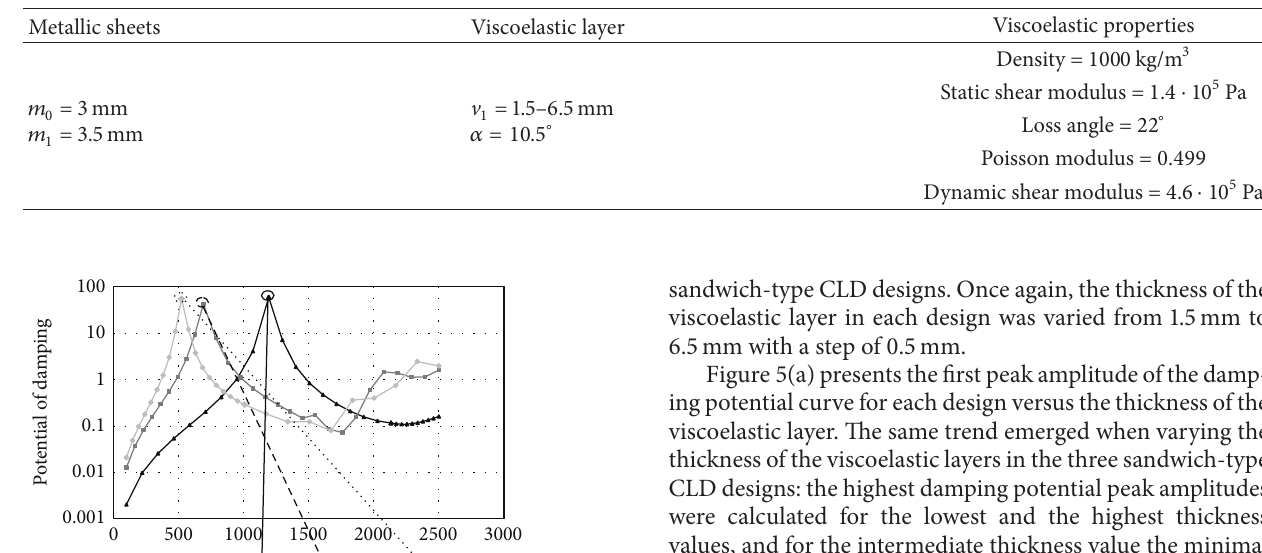
Table 5: Geometric parameters of the reference monolayer damper design.